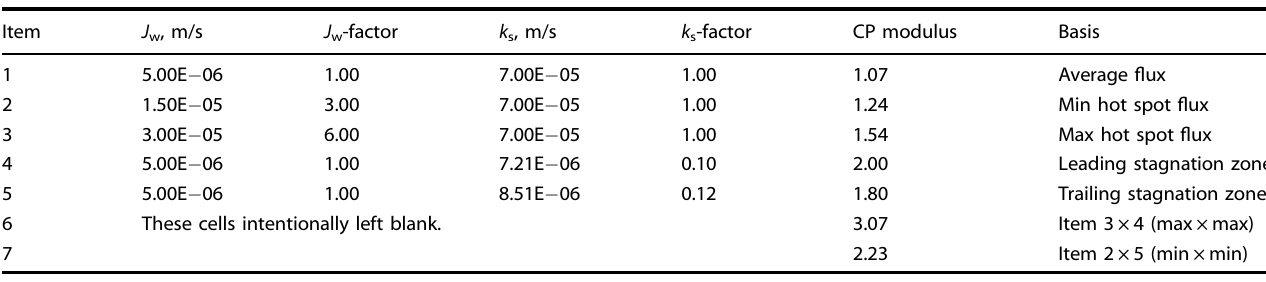
Table 5. Possible impacts of fl ux hot spots and stagnant zones.